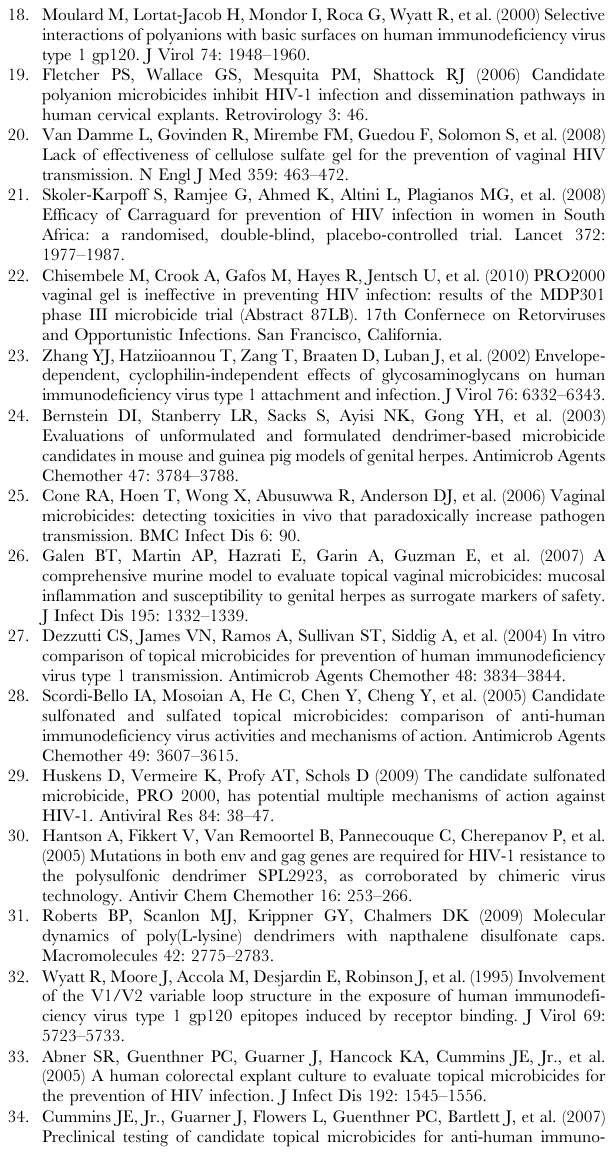
Table S2 SPL7013 has broad-spectrum activity against HIV-1 strains in human PBMC.